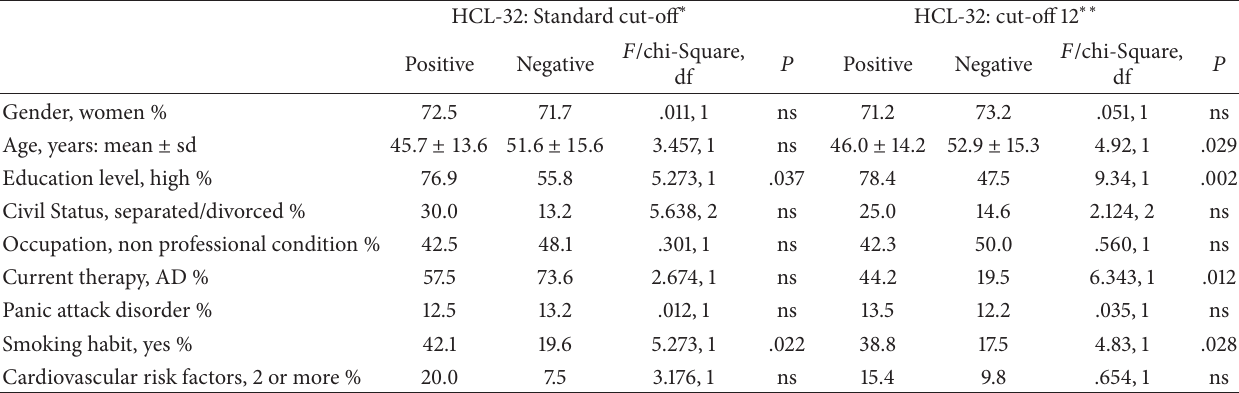
Table 6: Demographic and clinical characteristics according to threshold score on the